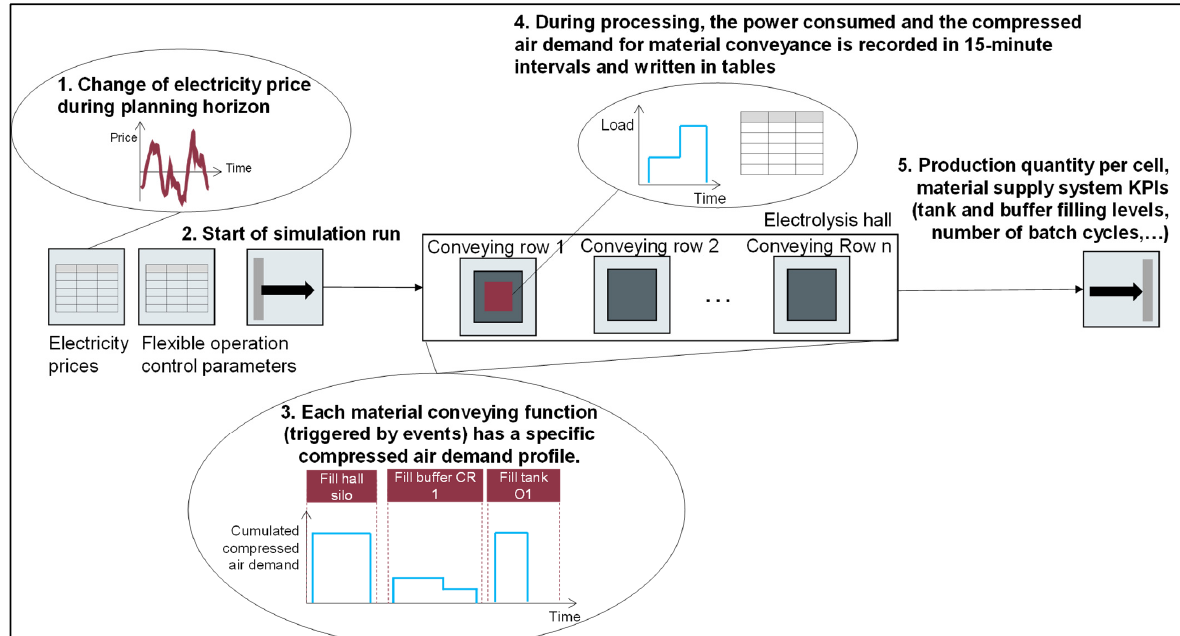
Figure 7. Schematic representation of the material and energy flows in use case 4.